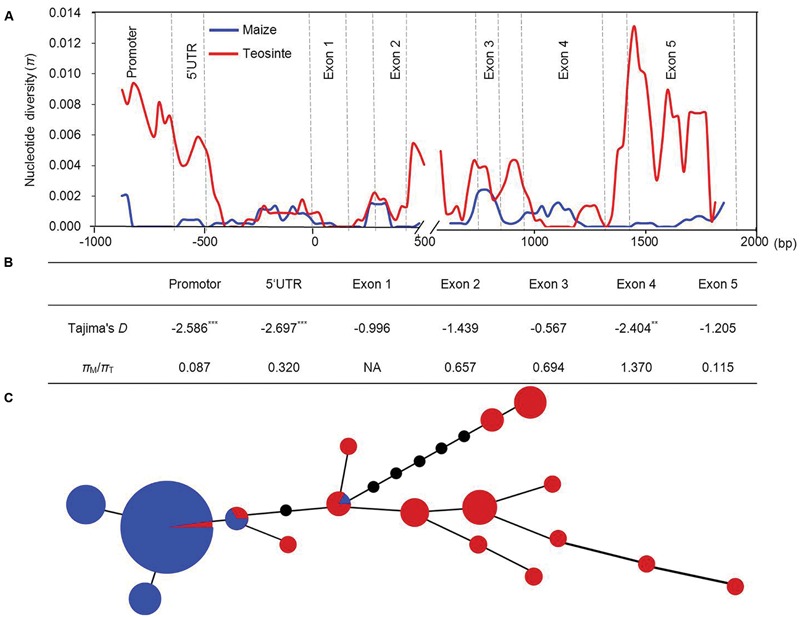
Sequence diversity of the ZmVDE1 locus between maize and teosinte. (A) Nucleotide diversity revealed by comparisons between 89 maize lines and 44 teosinte entries across the ZmVDE1 locus. Nucleotide diversity (π) for teosinte and maize was shown. (B) Tajima’s D test for non-neutral evolution and the ratios of π in maize (πM) to π in teosinte (πT) are shown. **P < 0.01; ***P < 0.001. (C) A minimum-spanning tree for ZmVDE1 including 89 diverse maize sequences and 44 diverse teosinte sequences. Each haplotype group is represented by a circle with a color, and circle sizes represent the number of lines within the haplotype. Red and blue represent teosinte and maize, respectively.